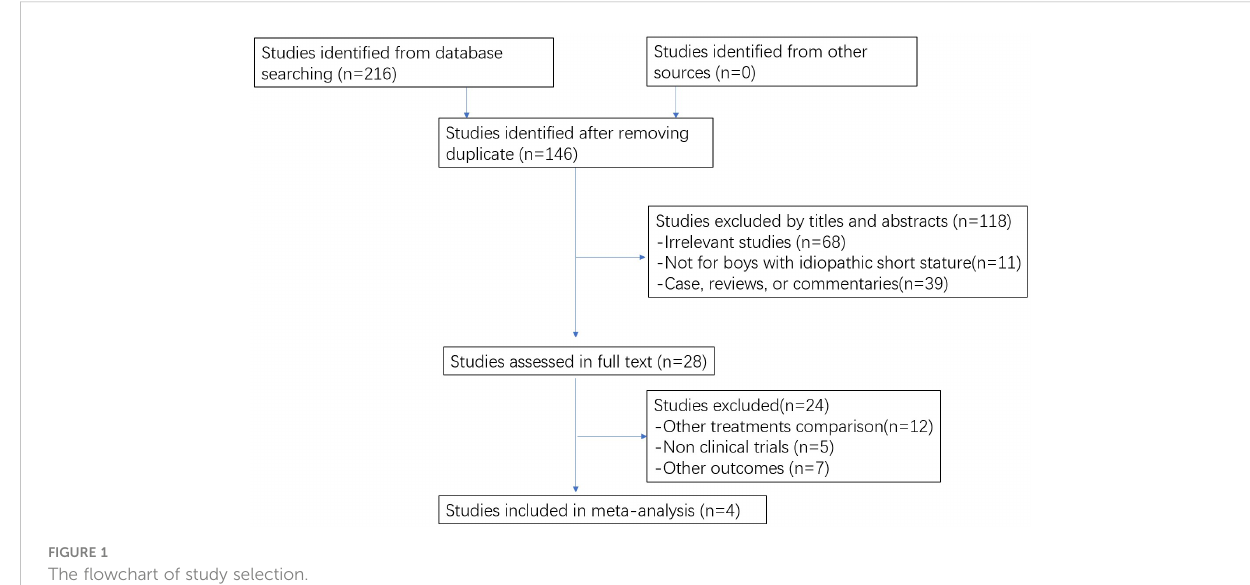
FIGURE 1 The fl owchart of study selection.